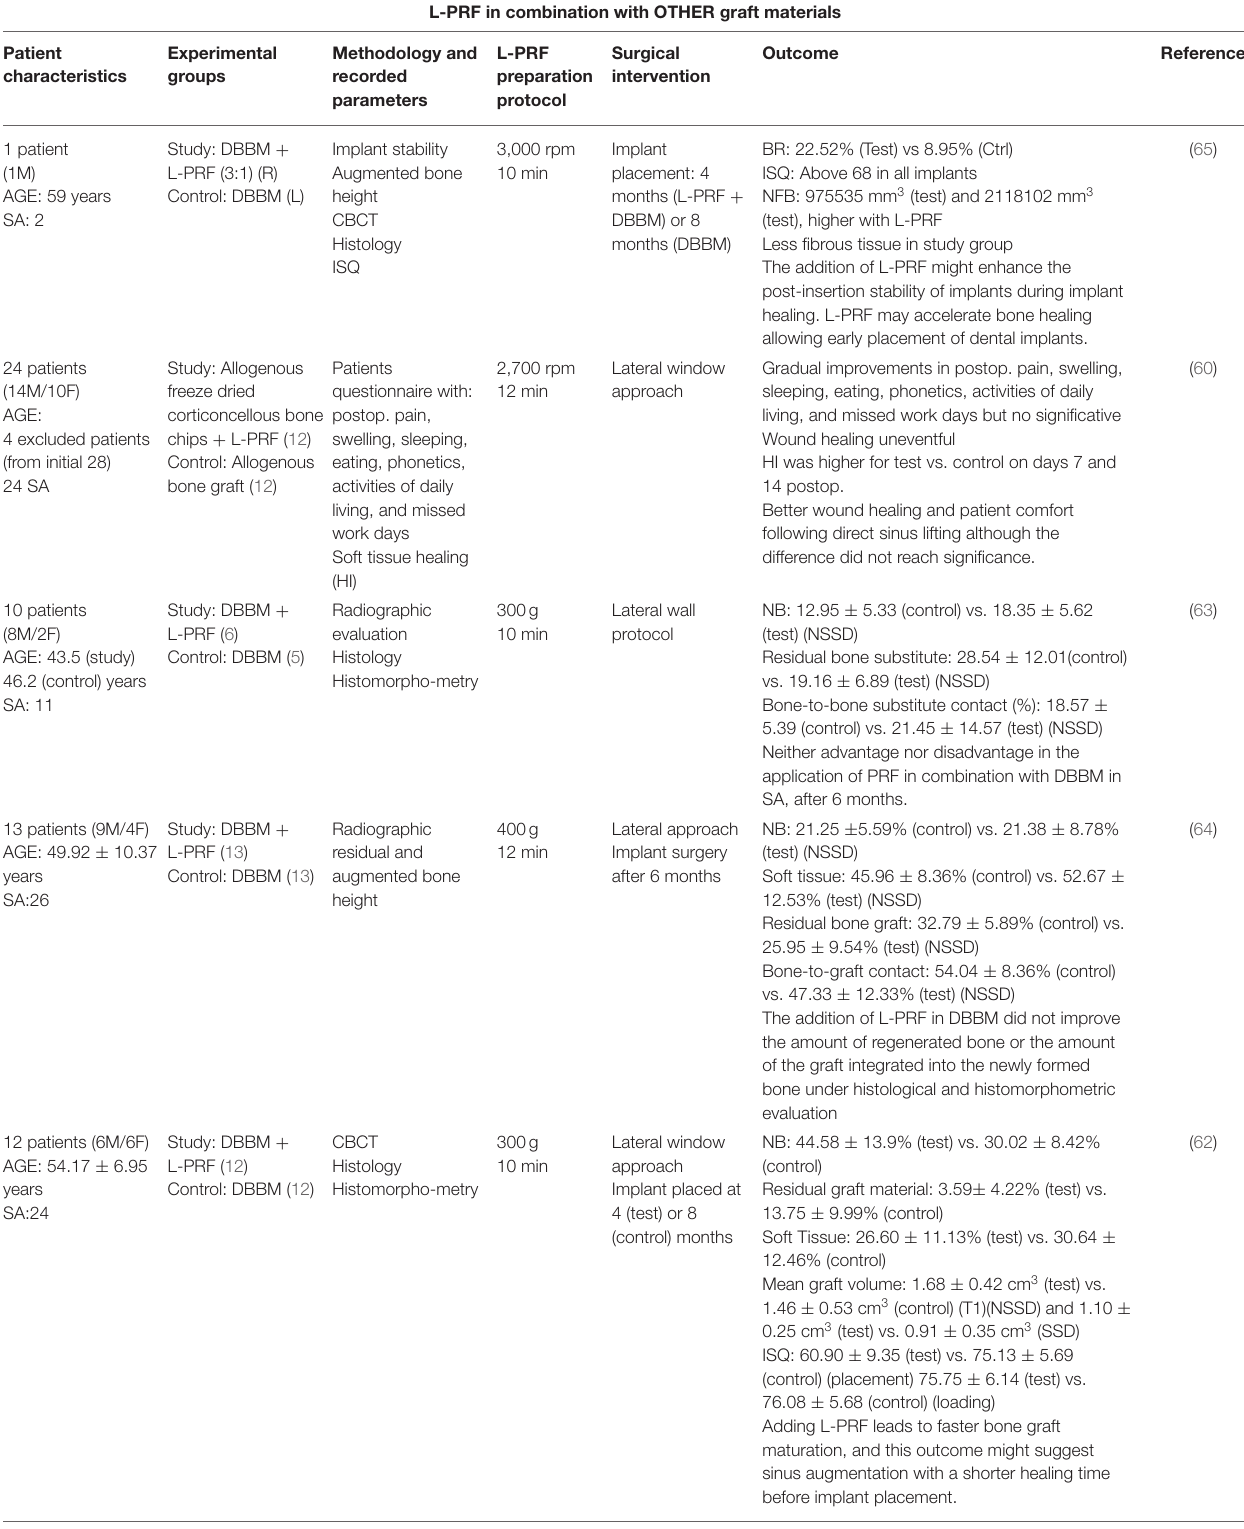
TABLE 3 | Studies on L-PRF and maxillary sinus augmentation with L-PRF in combination with OTHER graft materials. L-PRF in combination with OTHER graft materials Patient